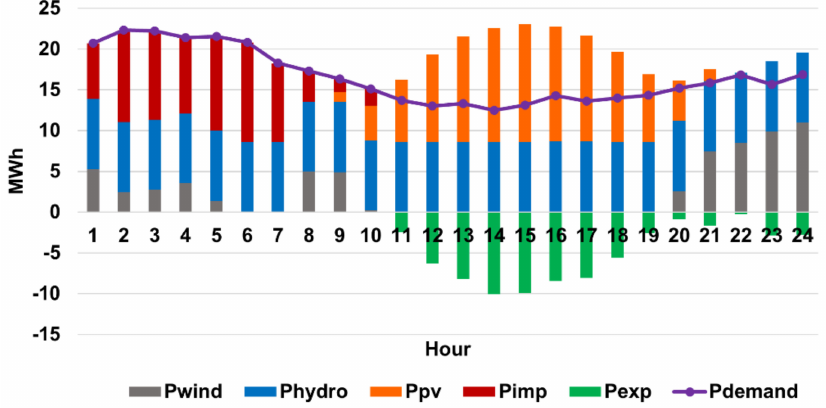
Figure 4. Results of optimal dispatch for a day in June (24 / 06 / 2017).